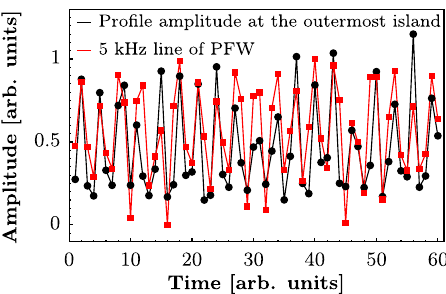
_ B FIG. 5. Top: The FFTof measured on an argon cycle reveals an important peak at 5 kHz. Bottom: The amplitude of the peak at FIG. 6. Comparison between the time evolutions of the mea- 5 kHz shown in the top figure oscillates in the same way as the sured profile amplitude of the outermost island and the amplitude amplitudeof the sideband of the horizontaltunediscussed in Fig.4. of the 5 kHz current ripple of the PFWs.